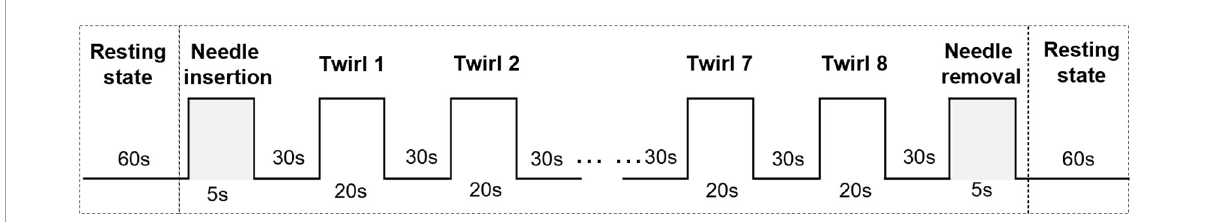
FIGURE4 Experimental paradigm. The first task was needle insertion (NI). The second task was needle twirl, which was repeated eight times (T1, T2 ...... T8). The last task was needle removal (NR).